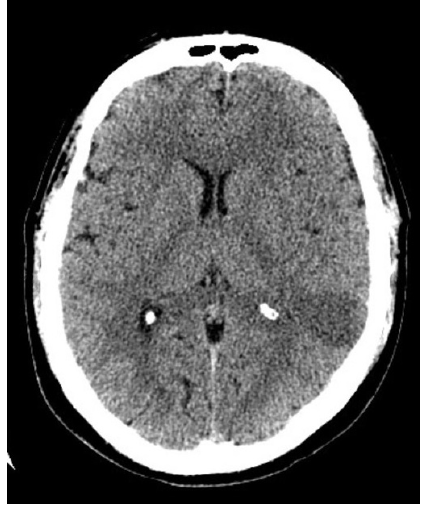
Figure 1. CT scan of the brain after 24 h after admission to the hospital shows an ischemic stroke (30 × 25 × 60 mm) in the left temporal lobe.